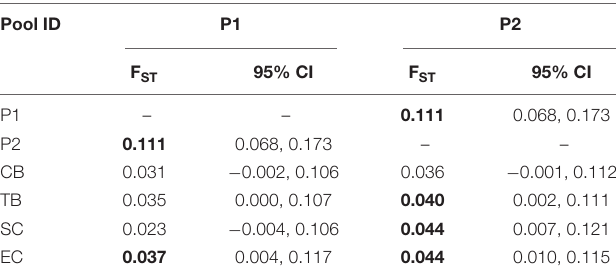
TABLE 4 | Estimates of pairwise genomic differentiation (F ST ) and 95% confidence intervals (95% CI) for South African sampling sites/pools, based top 500 loci